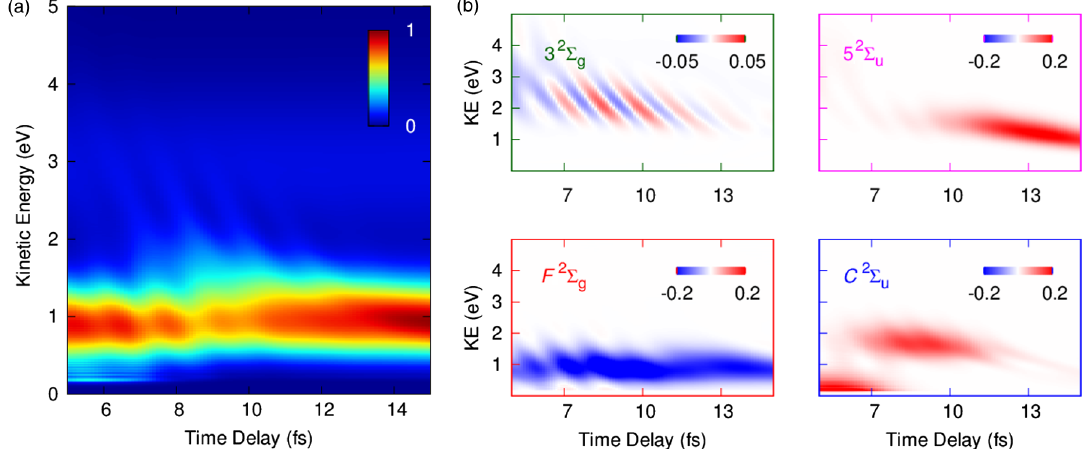
FIG. 8. Time-dependent N þ kinetic energy (KE) spectra calculated (a) within the four-state model and (b) for each individual state of this model. To clearly show the effect of the probe pulse, the KE spectrum corresponding to a calculation without probe pulse is subtracted from each of the panels reported in (b).